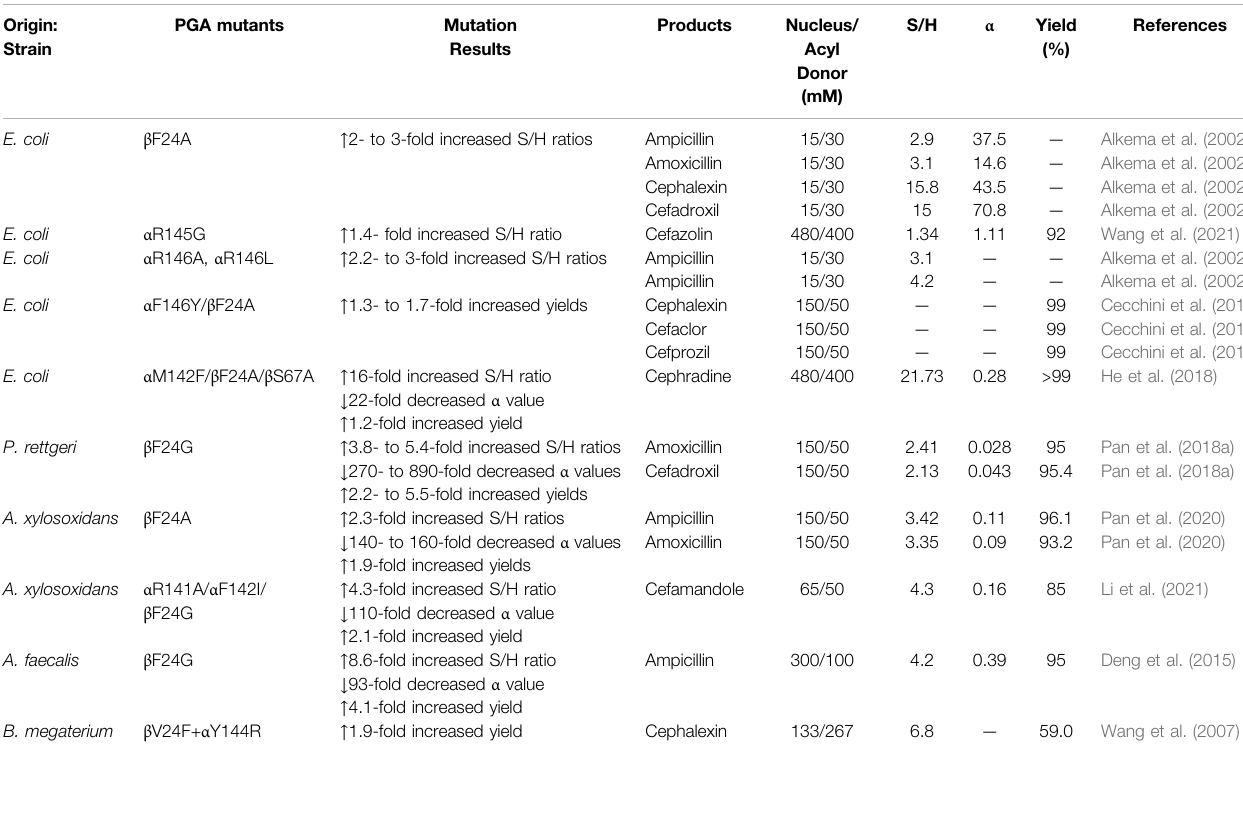
TABLE 2 | Effect of site-directed mutations on the synthesis performances of PGAs. Origin: